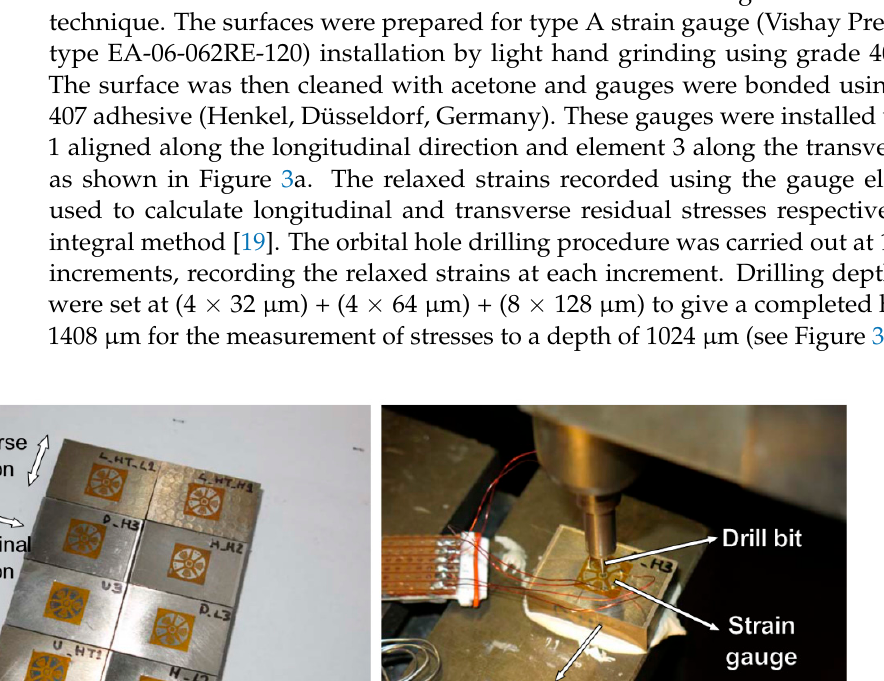
Table 3. Processing conditions used for controlled hammer peening (CHP).